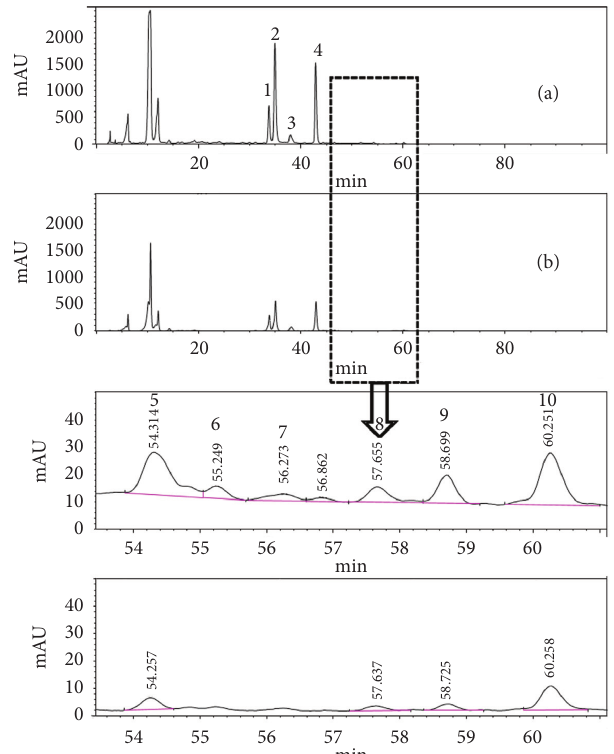
Figure 5: The chromatographic profiles of the 20% formic acid-methanol extract (a) and methanol extract (b) of L. japonica decoction. Table 2: Retention time and peak area of L. japonica decoction ( X ± S , n � 3). 20% formic acid-methanol No.